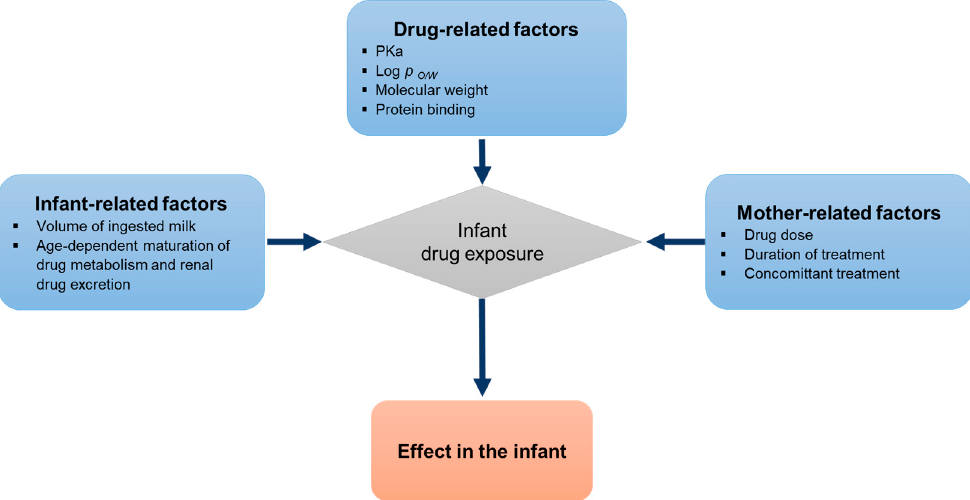
Figure 1. Factors influencing infant drug exposure by nursing.